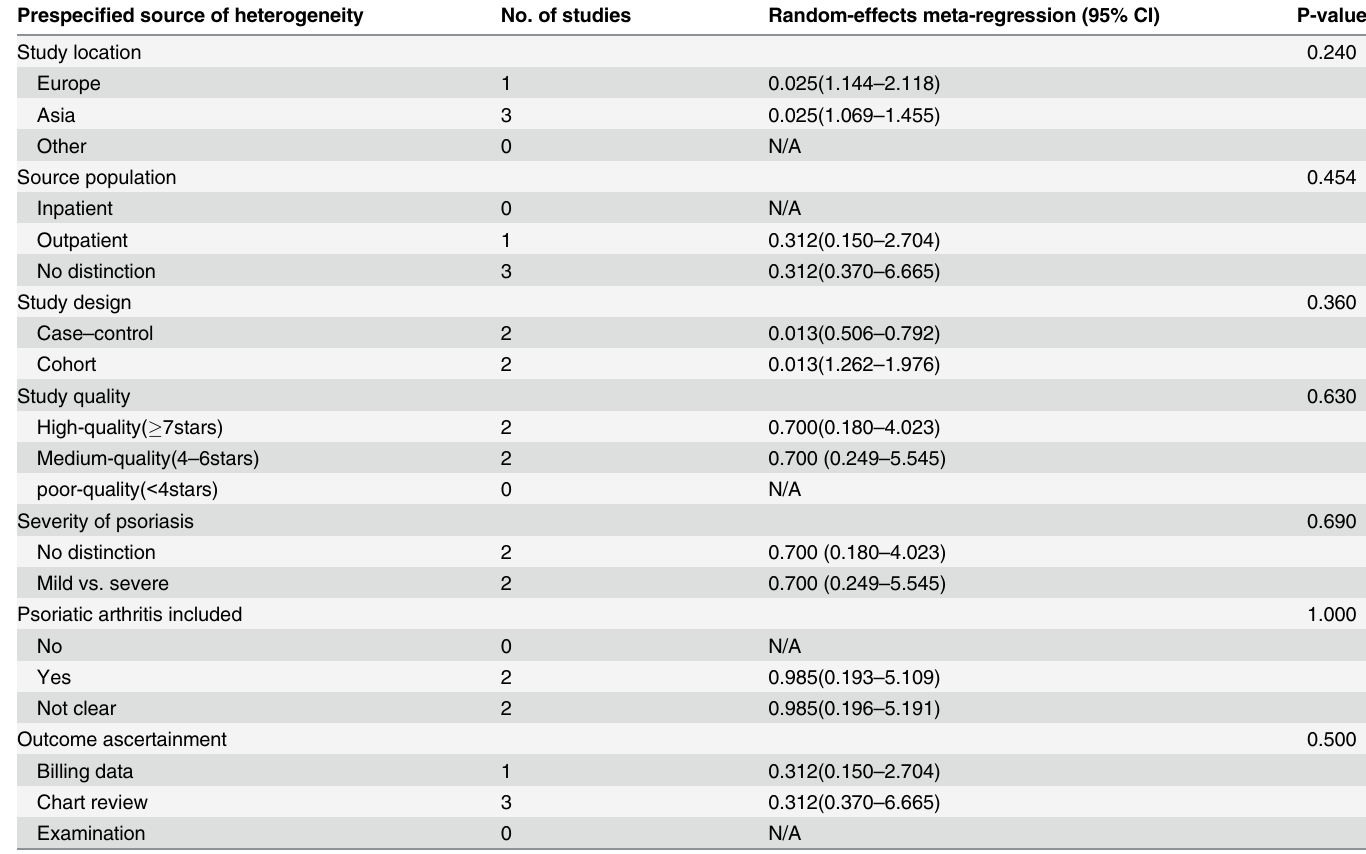
Table 3. Potential prespecified sources of heterogeneity explored among studies reportingan association between psoriasis and COPD. Prespeci fi ed source of